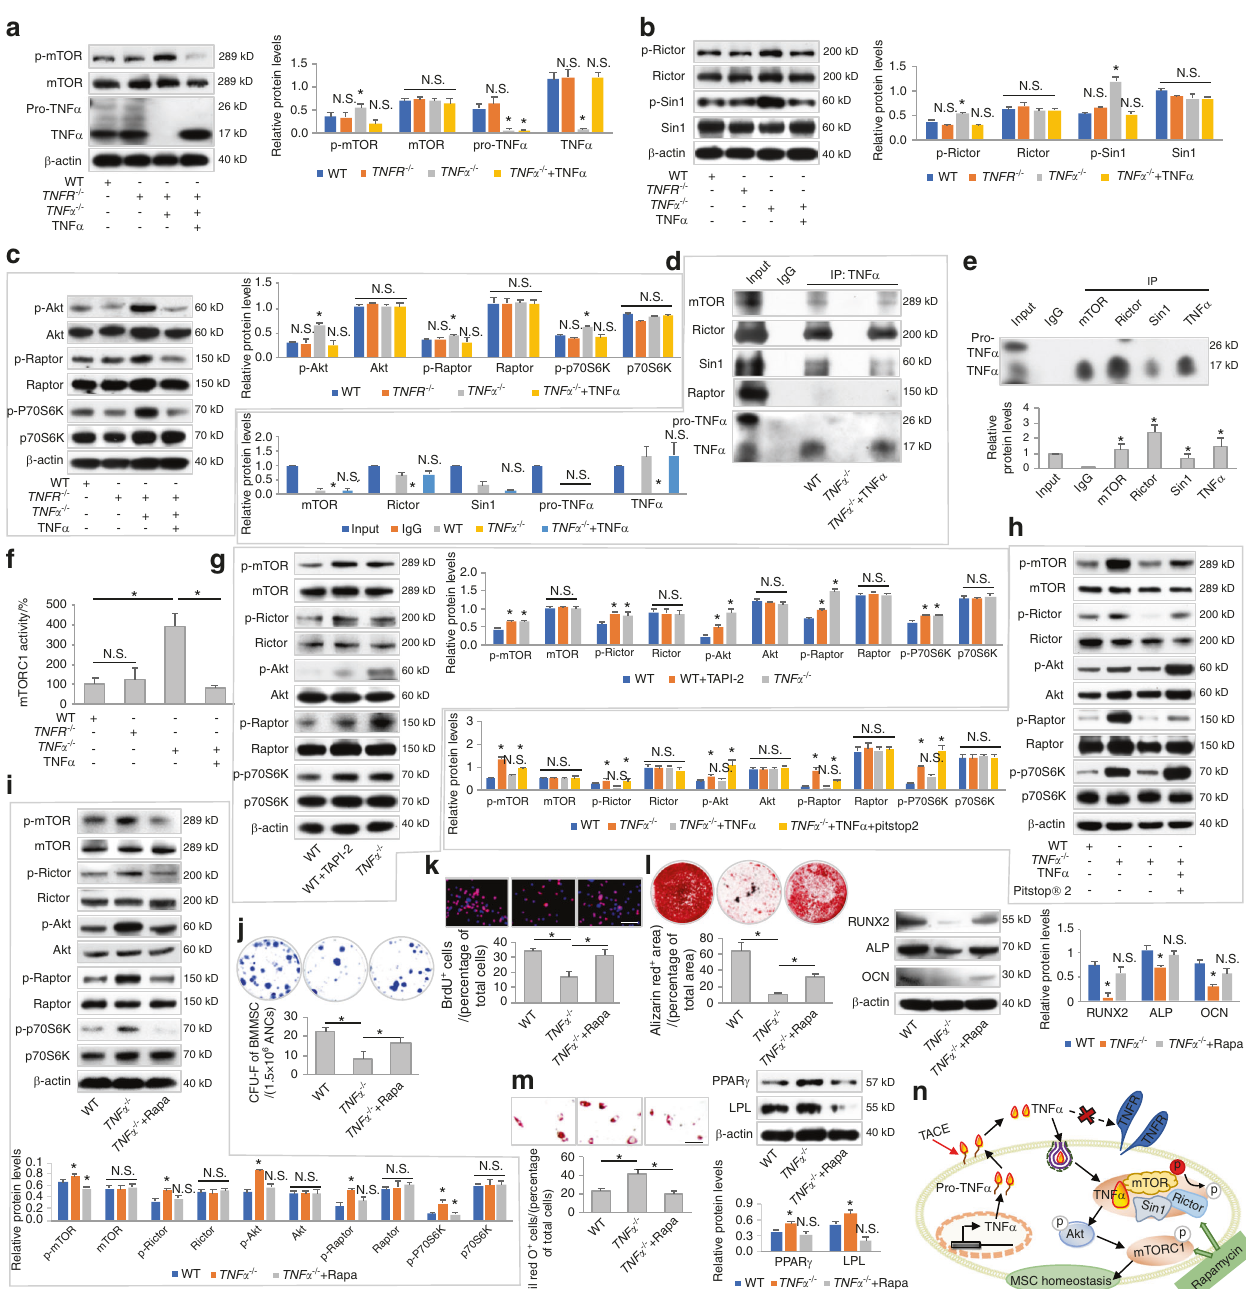
Fig. 3 Endocytosed TNF α binds to mTORC2 and restricts activation of mTOR signaling for functional regulation of MSCs. a – c Western blot analyses of mTOR signaling in response to TNFR or TNF α de fi ciency. N = 3. TNF α was added at 1 ng·mL − 1 . d , e Co-IP analyses of the binding of TNF α to mTOR complex components ( N = 3). f Analysis of mTORC1 activity using an ELISA-based assay ( N = 3). g – i Western blot analyses of mTOR signaling. N = 3. TAPI-2, TNF α , Pitstop ® 2, and rapamycin (Rapa) were added at 120 nmol·L − 1 , 1 ng·mL − 1 , 12 μ mol·L − 1 , and 50 nmol·L − 1 , respectively, in vitro. j – m Functional analyses of MSCs according to CFU, BrdU labeling, and osteogenic and adipogenic differentiation ( N = 3). Scale bars = 100 μ m. n Diagram showing TNF α binding to mTORC2 and restricting activation of mTOR signaling for functional regulation of MSCs. For quanti fi cation of Western blotting, a two-tailed Student ’ s t test was used for the comparison between the treatment and WT groups. * P < 0.05. N.S. not signi fi cant. Data represent the mean ±